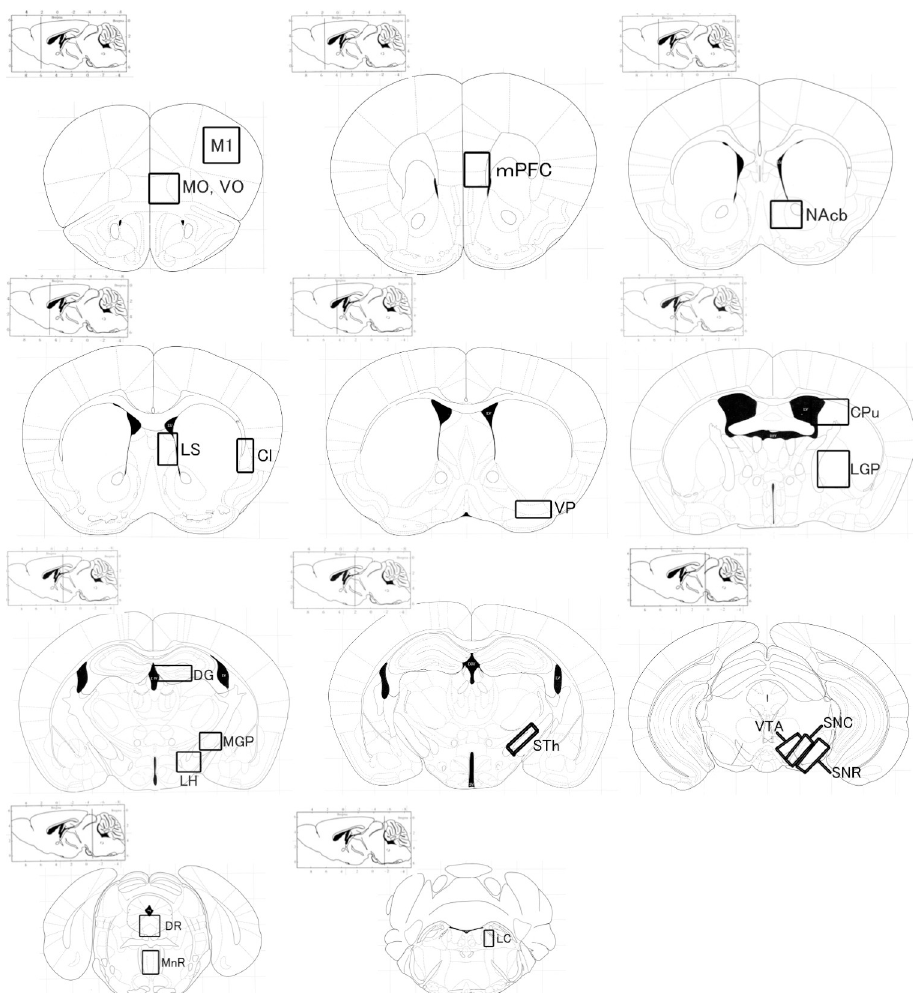
nucleus; Cl: claustrum; NAcb: nucleus accumbens; VP: ventral pallidum; LGP: lateral globus pallidus; CPu, caudate putamen; DG: dentate gyrus; MGP: medial globus pallidus; LH: lateral hypothalamus; STh: subthalamic nucleus; VTA: ventral tegmental area; SNC: substantia nigra, pars compacta; SNR: substantia nigra, pars reticulate; DR: dorsal raphe nucleus; MnR: median raphe nucleus; LC: locus